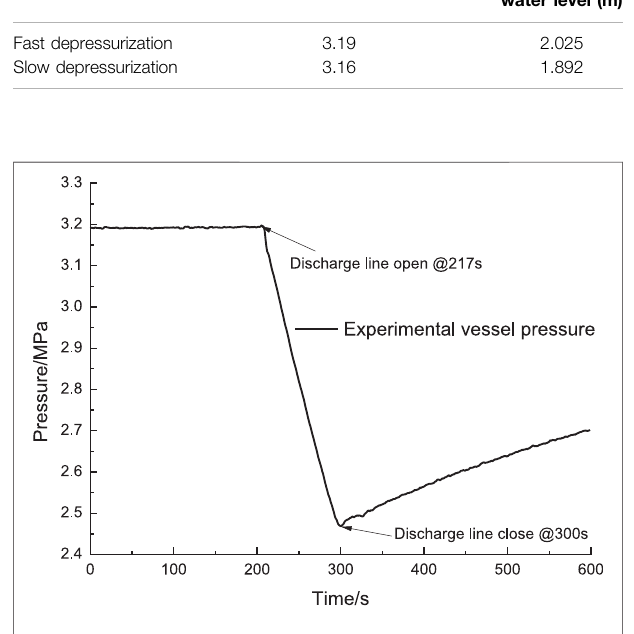
FIGURE 4 | Vessel pressure of the fast depressurization.